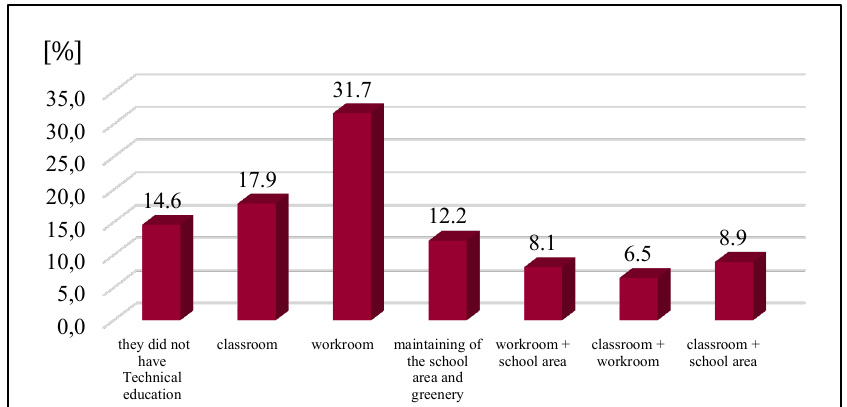
Fig. 4. Results in answers to the item no. 3: „Write in whic places you had the lessons of Technical education